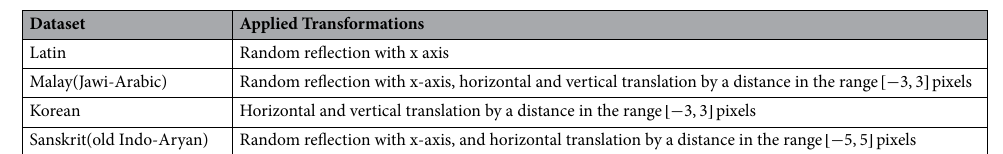
Table 3. The applied traditional transformations in each dataset for Case ( B